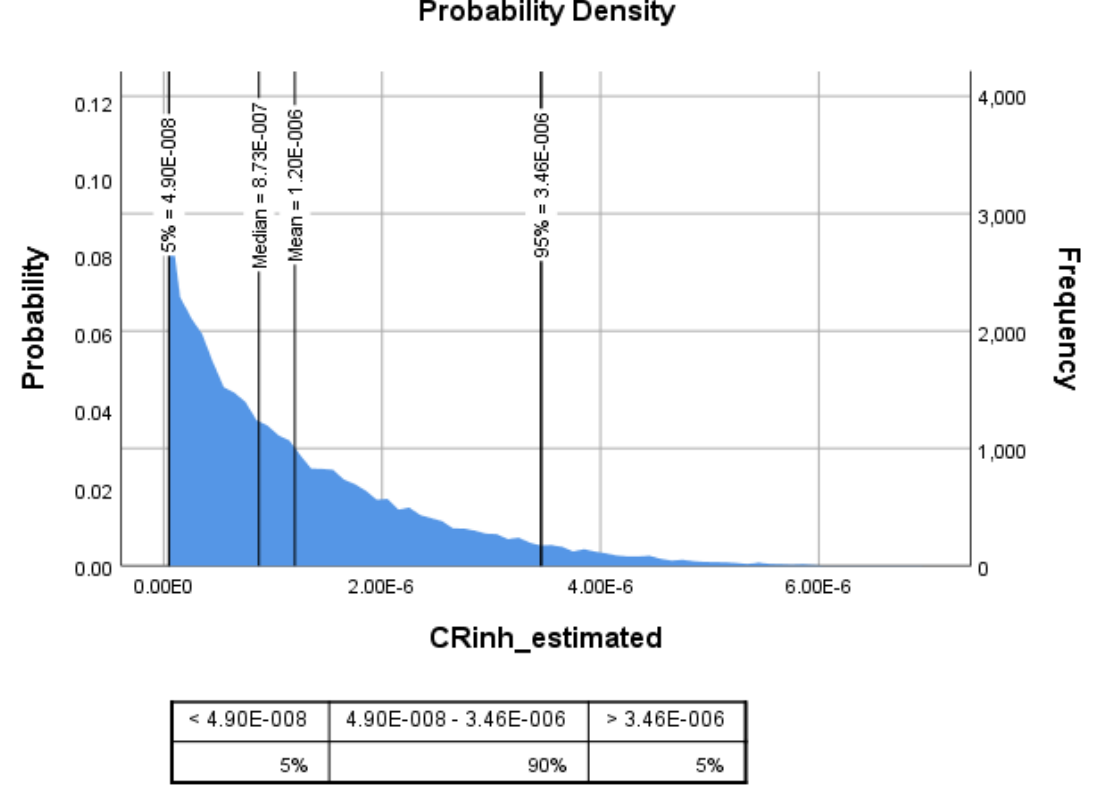
Figure 3. Inhalation cancer risk resulting from personal exposure to DEHP (CR inh ) and estimated exposure to DEHP (CR inh_estimated ) using the time-weighted model. Note: 1.0E-06 = 1.0 × 10 − 6